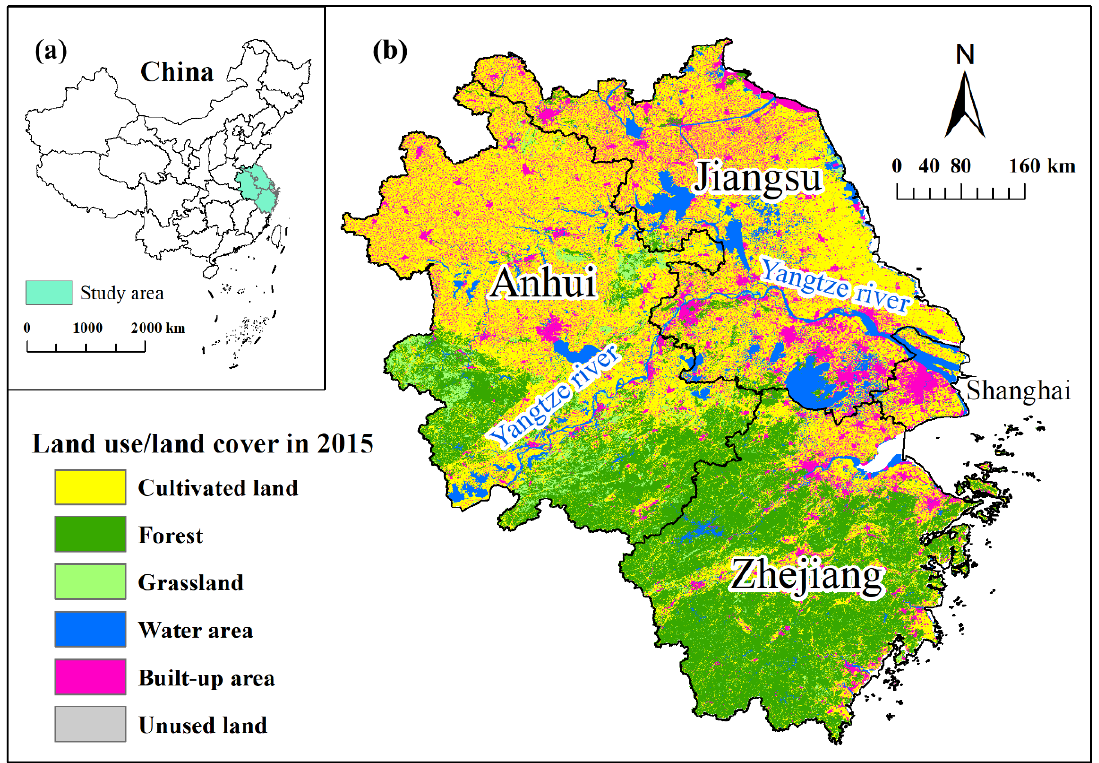
Figure 1. ( a ) The location of the YRD region in China; ( b ) the land use/land cover (LULC) pattern of the YRD region in